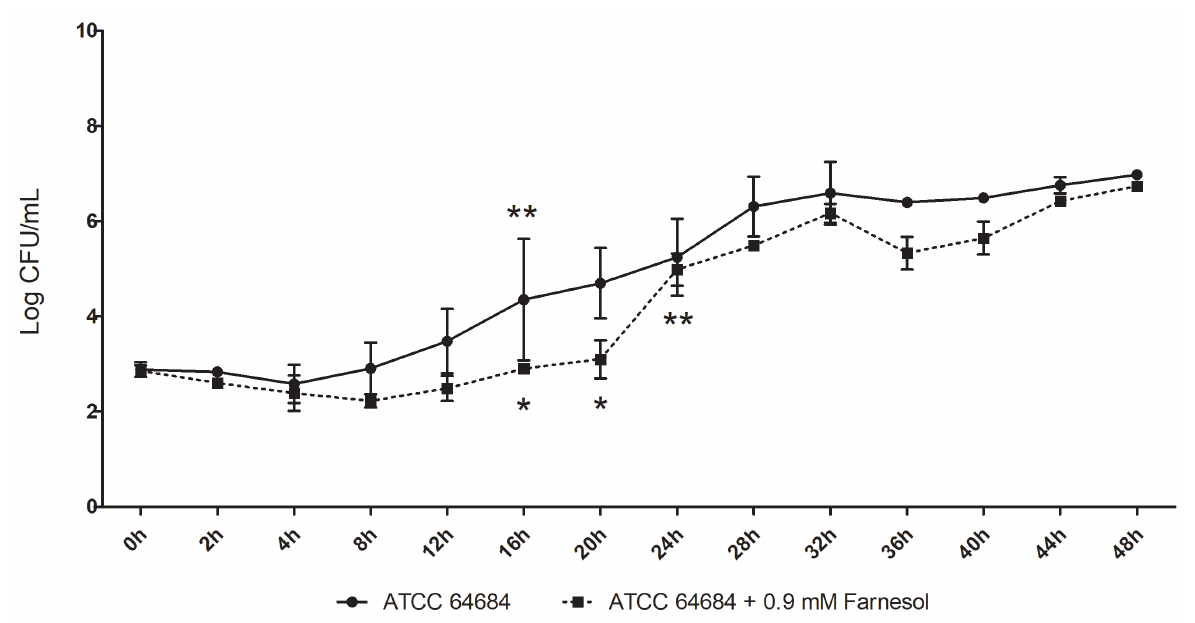
Figure 2. Growth kinetics of planktonic cells of Rhodotorula mucilaginosa ATCC 64684 in the presence of 0.9 mM farnesol compared with untreated planktonic cells. *Statistical difference between treated and untreated. **Significant increase over time. All tests were performed in triplicate and on three independent days. Data with a non-normal distribution were expressed as the mean ± standard deviation